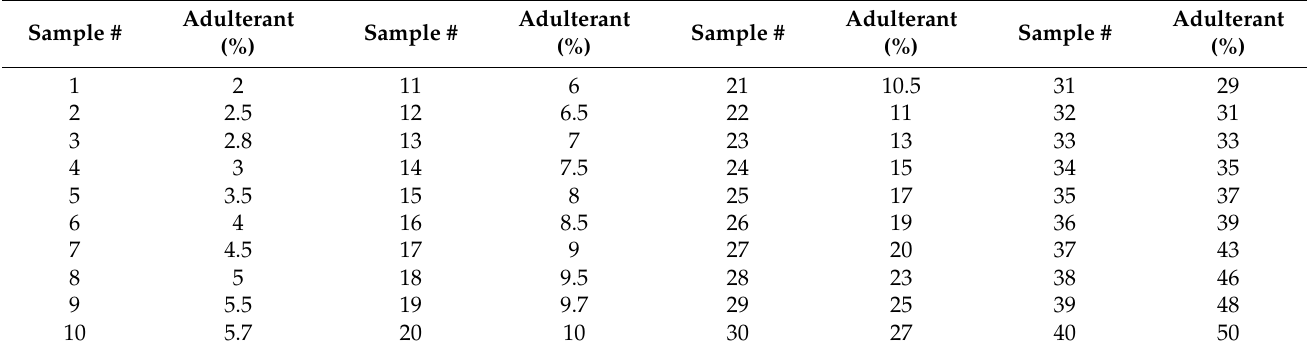
Table 1. Adulterated samples, percentage of the adulterant